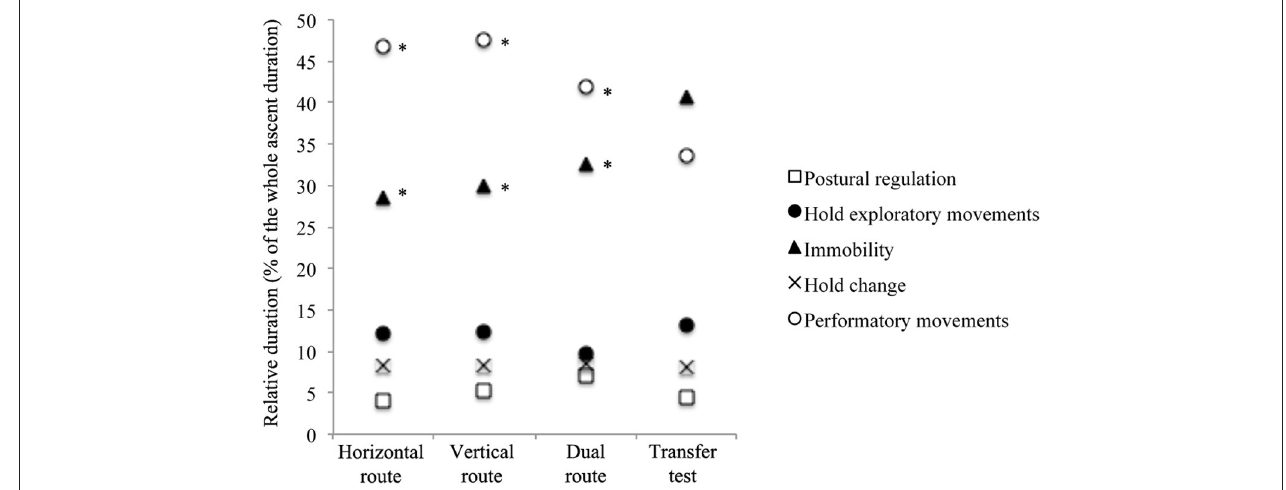
FIGURE 6 | Differences between the transfer test and the three routes performed during the learning protocol concerning the relative duration of each of the five climbing states. *Simple contrast tests showing significant differences between the transfer test and the fourth session of each route.